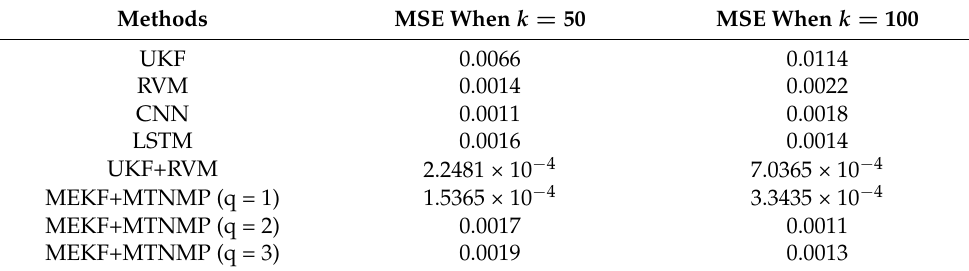
Figure 15. The simulation error diagram of B0007 predicted from the 100th time. ( a ) is the experimen- tal error of all methods, ( b ) is the error of other methods used for comparison in ( a ), and ( c ) is the error of the method proposed in this paper in ( a ). Table 2. Experimental results of B0005 lithium-ion battery.